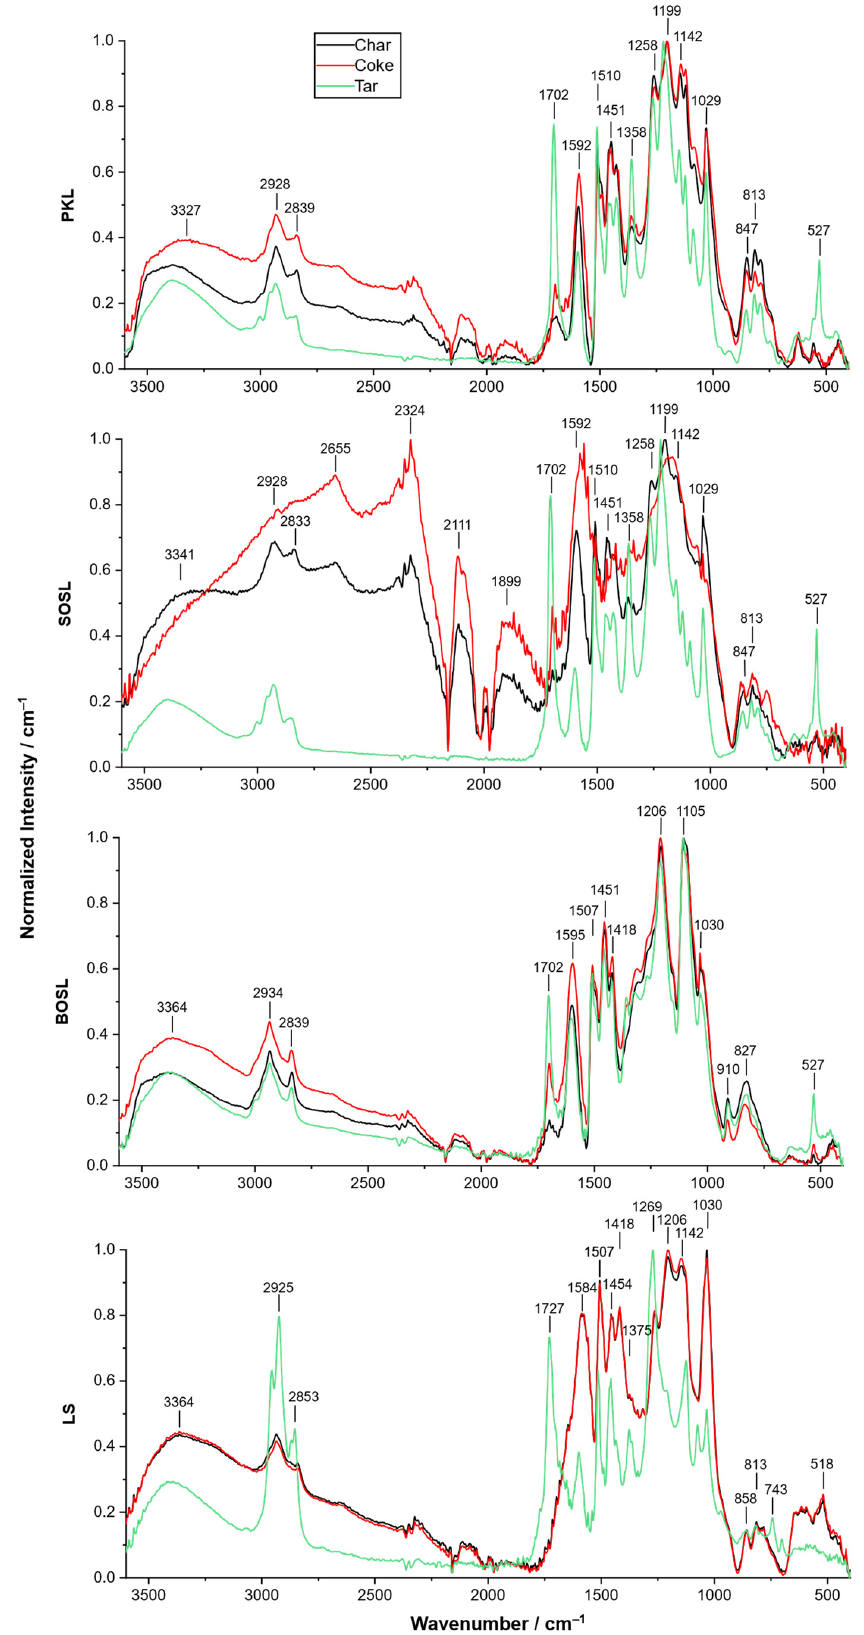
Figure 6. Normalized FTIR spectra of the chars (black), cokes (red), and tars (green) of the PKL, SOSL, BOSL, and LS.